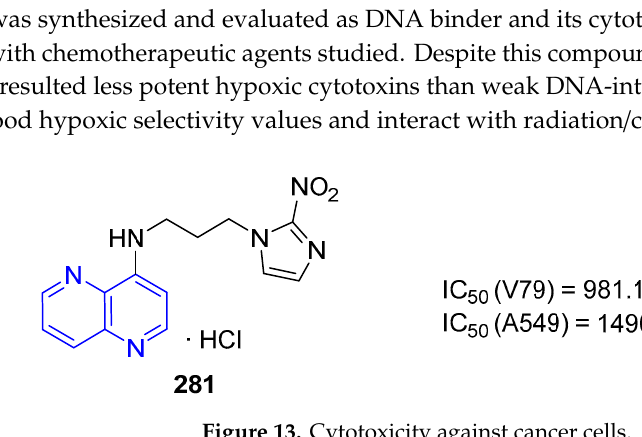
Figure 14. Antibacterial activity of 1,5-naphthyridine-containing macrolides.